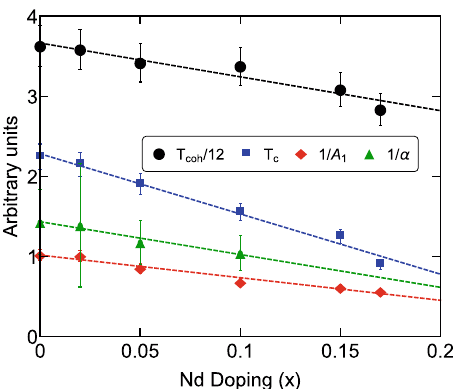
Fig. 2 | Linear-in- x dependence of T coh , T c and 1/ A 1 , and 1/ α . The data are taken fromref. 26 andTable1.Theerrorbarsof T coh , T c and1/ A 1 arisefromtheinaccuracy of tuning temperature, while the error bar for 1/ α includes the uncertainties of m ⋆ , n , and F shown in Table 1.